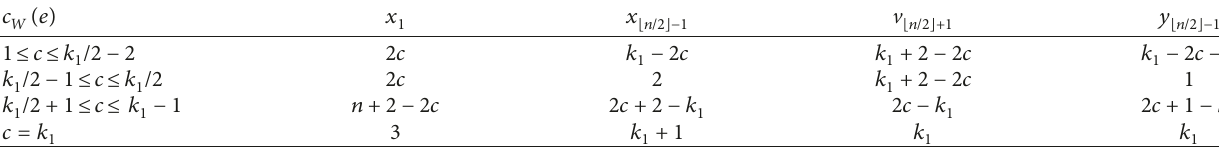
y c is even. c c , when